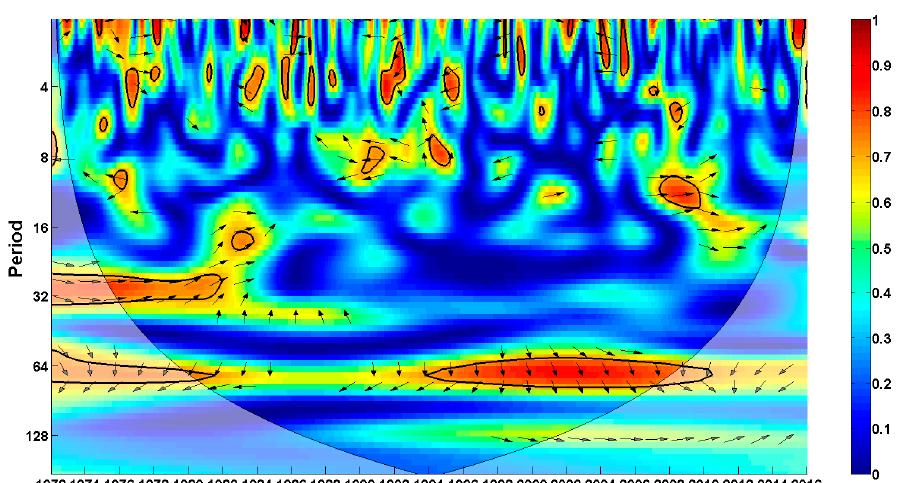
Figure 5. Wavelet Coherence of SAMi and SOI (a). The thick black contour encloses regions of confidence for a red-noise process greater than 95%. Thin black lines designate the COI where the edge effects might affect the results. In these spectra, low values of the scale match the high frequencies. Black arrows indicate the phase relationship between the two signals (with in-phase pointing right and anti-phase pointing left).